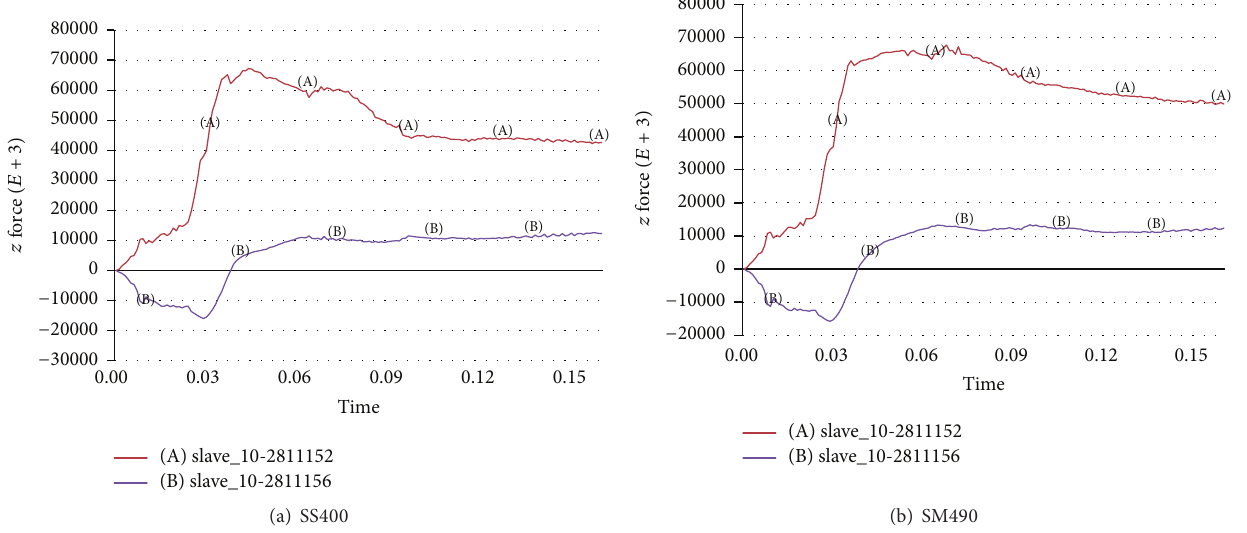
Figure 11: Induced vertical forces in the 𝑧 -axis at the point of failure force measurement for the full contact condition.